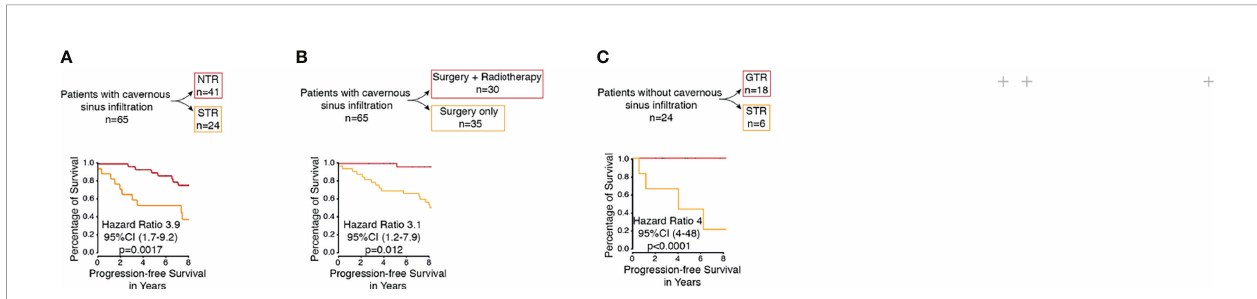
FIGURE 2 | (A) Kaplan – Meier curve of patients with PCM with in fi ltration of the cavernous sinus for progression-free survival based on extent of resection (NTR vs. STR). (B) Kaplan – Meier curve of patients with PCM with in fi ltration of the cavernous sinus for progression-free survival based on therapy (surgery vs. surgery plus radiotherapy). (C) Kaplan – Meier curve of patients PCM without in fi ltration of the cavernous sinus for progression-free survival based on extent of resection (GTR vs.